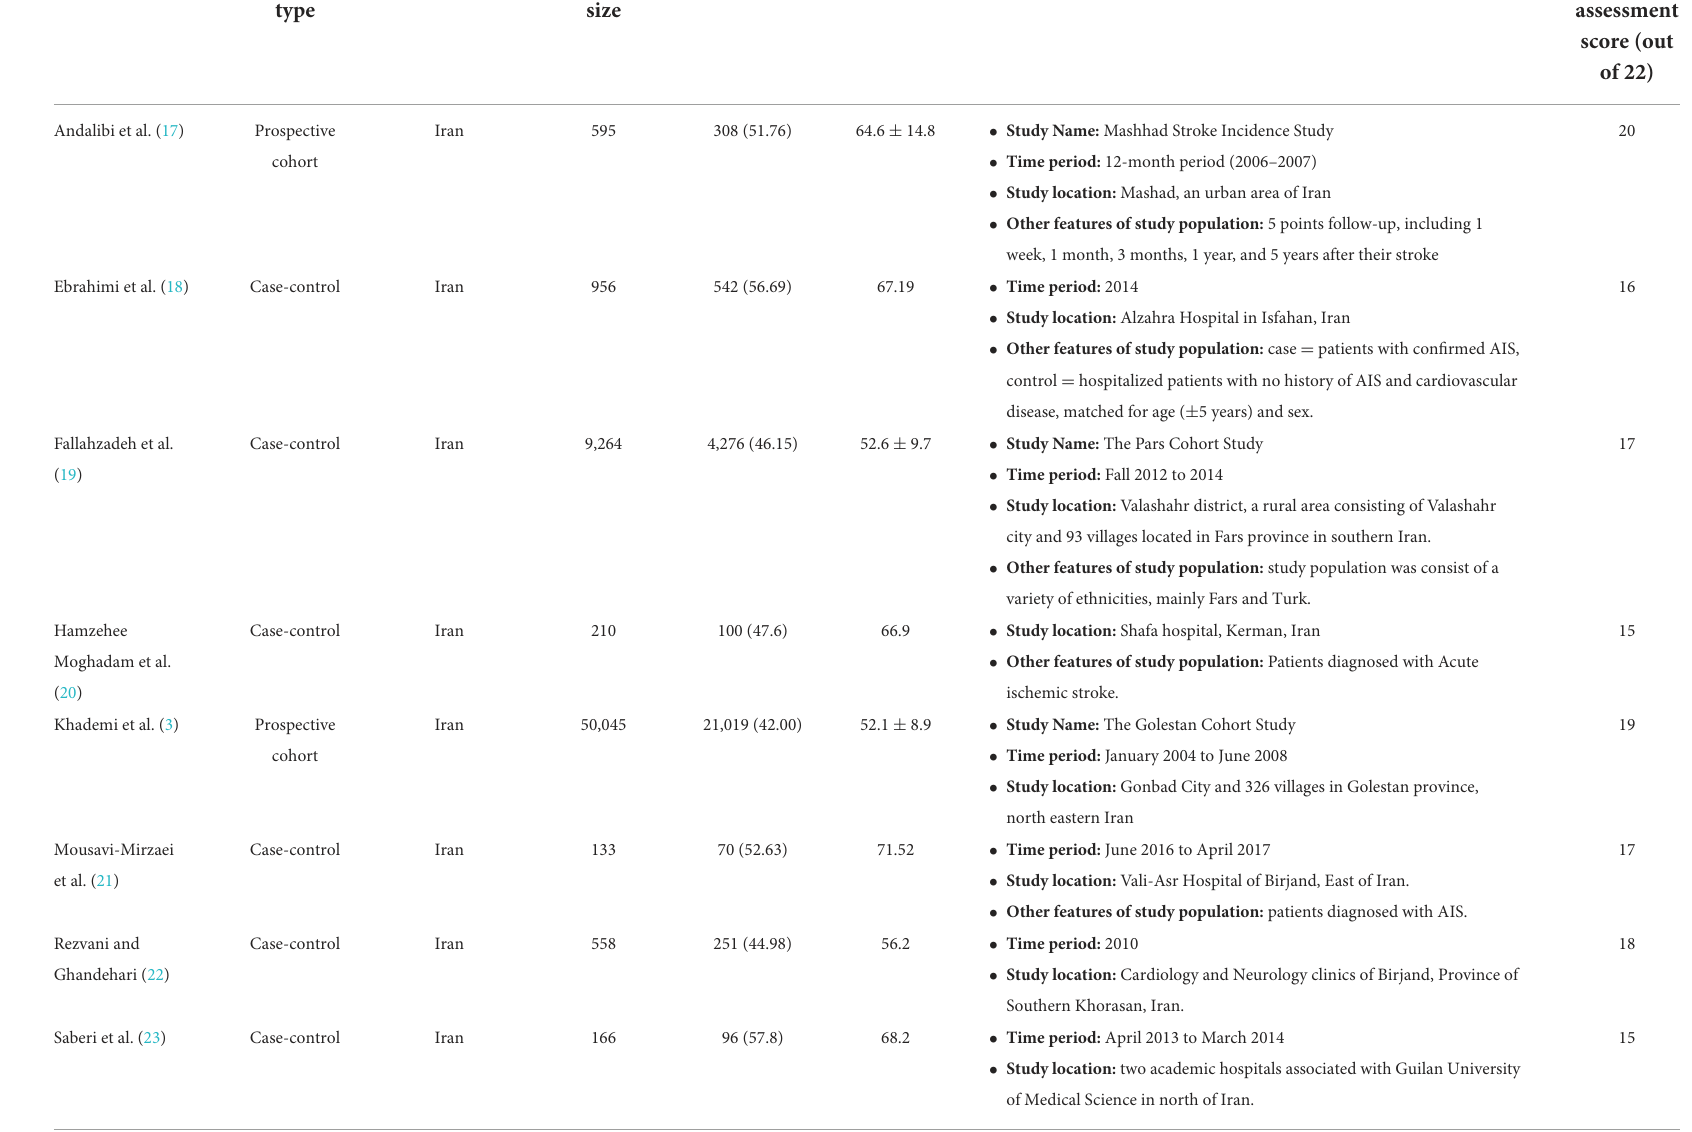
TABLE 1 Demographic characteristics of participants of included